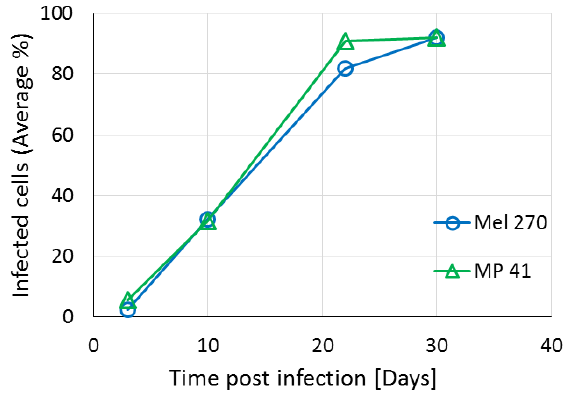
Figure 2. vACE-GFP spread in UM cell lines. The UM cell lines Mel270 and MP41 were infected by vACE-GFP. The cells were harvested every 6 – 7 days and the percent of infected cells was determined by flow cytometry. Readings were processed by the FCS Express 4 Flow Research Edition. The standard deviations are smaller than the graph ’ s resolution.